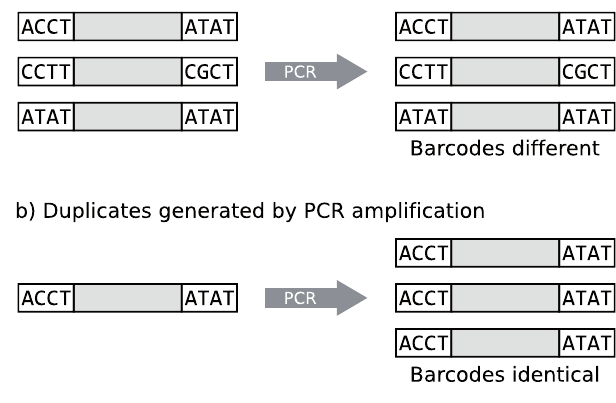
Figure 4. Experiment to determine whether Hi-C duplicates represent genuine independent interaction events or are the product of PCR amplification. The diagram shows di-tags (shaded rectangles) delimited by a pair of barcoded sequencing adapters.